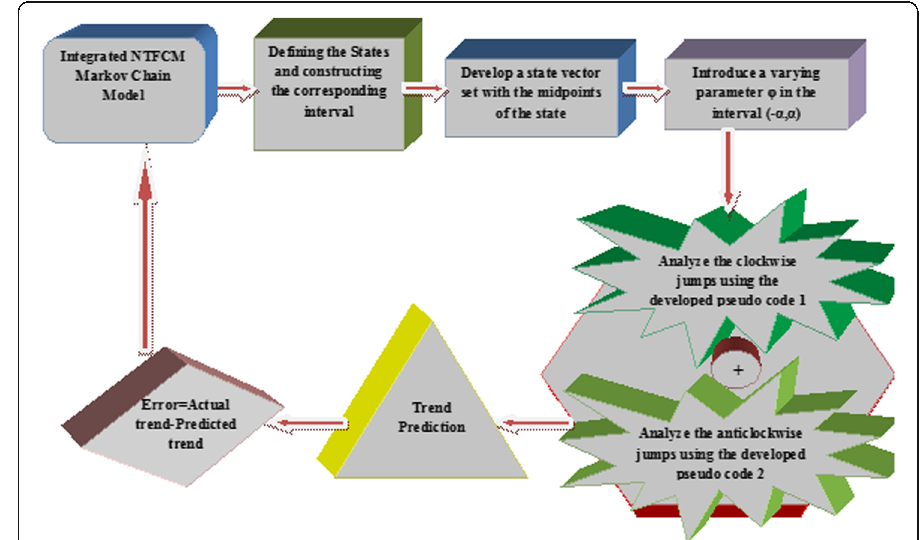
Fig. 1 Research Design Integrating Markov Chain and Fuzzy